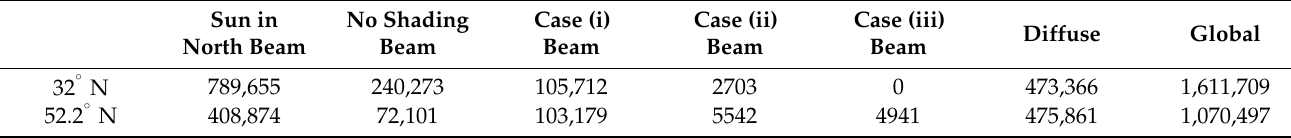
Table 3. East-facing surface: yearly incident irradiation,